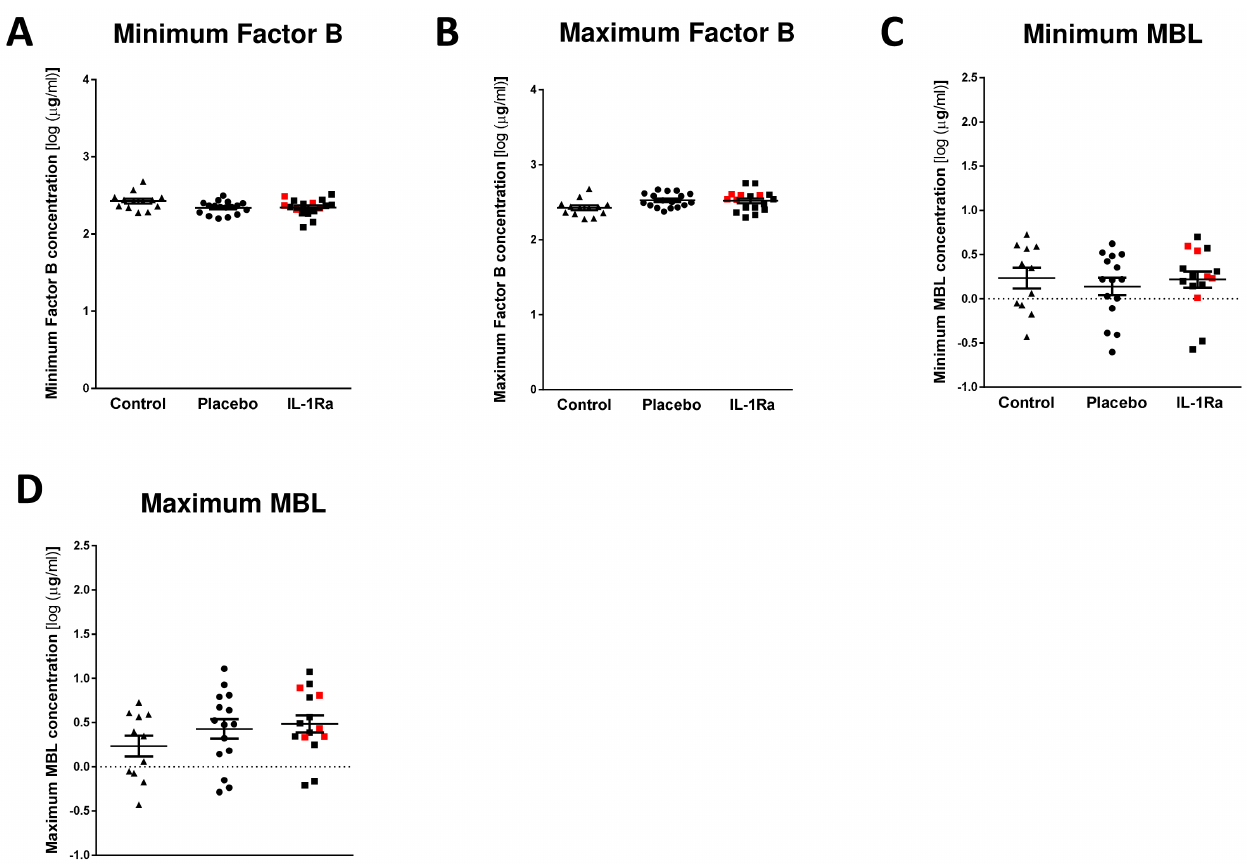
Figure 4. Treatment with IL-1 receptor antagonist (IL-1Ra) has no additional effect on complement components unaffected by stroke. Minimal and maximum concentrations of ( A , B ) Factor B and ( C , D ) mannose-binding lectin (MBL) were measured in the first seven days after stroke were unchanged in both placebo and IL-1Ra treated patients in comparison to healthy controls. Data show mean ±SD, one-way ANOVA with Bonferonni correction.